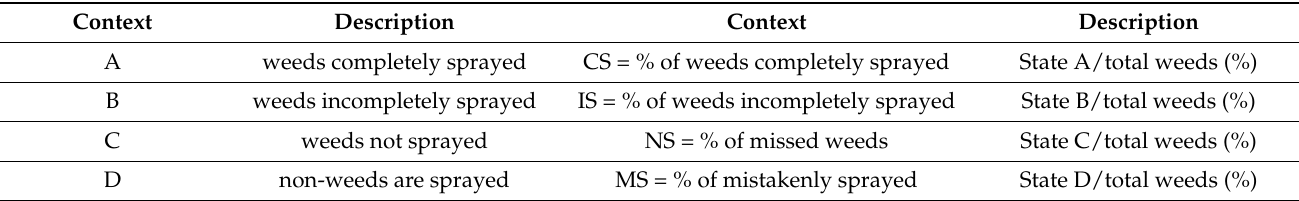
Table 1. Detail of the spraying system assessment